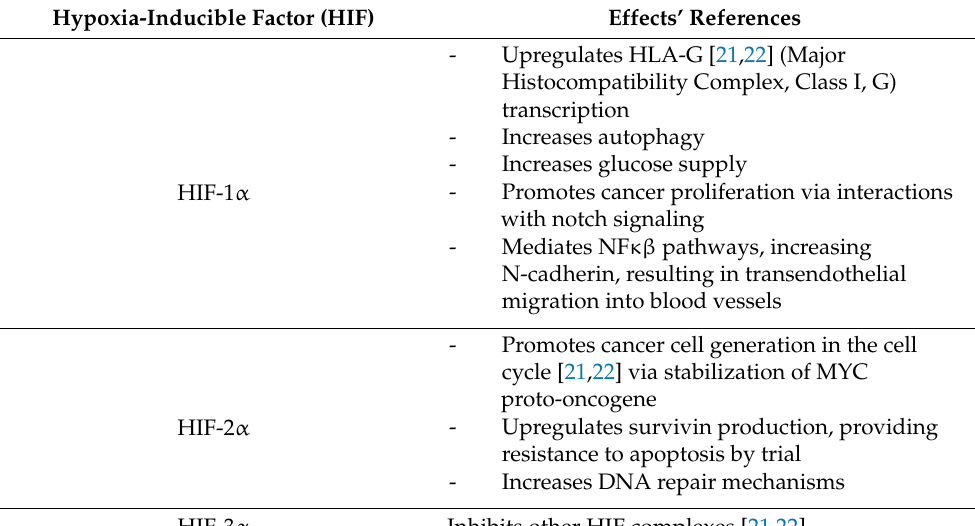
Table 2. Summary of hypoxia-inducible factors and the resultant effects that aid in the survival of the pancreatic tumor.